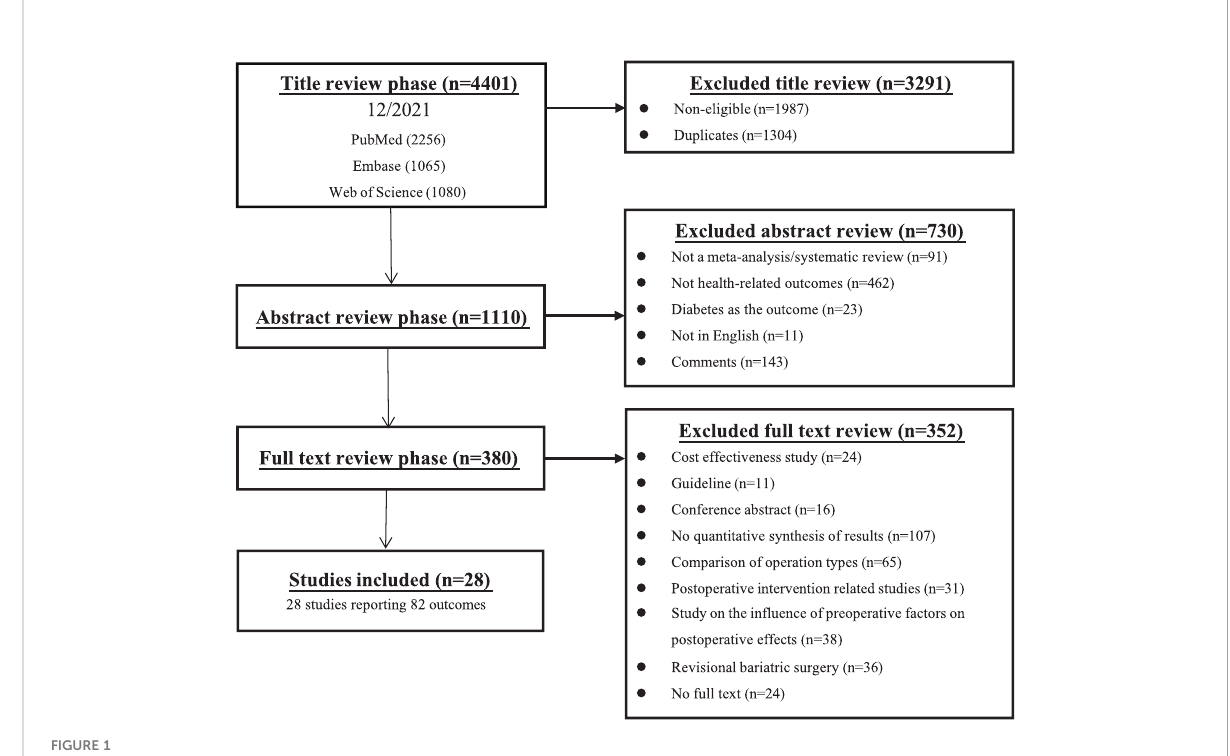
FIGURE 1 Flowchart of the article selection